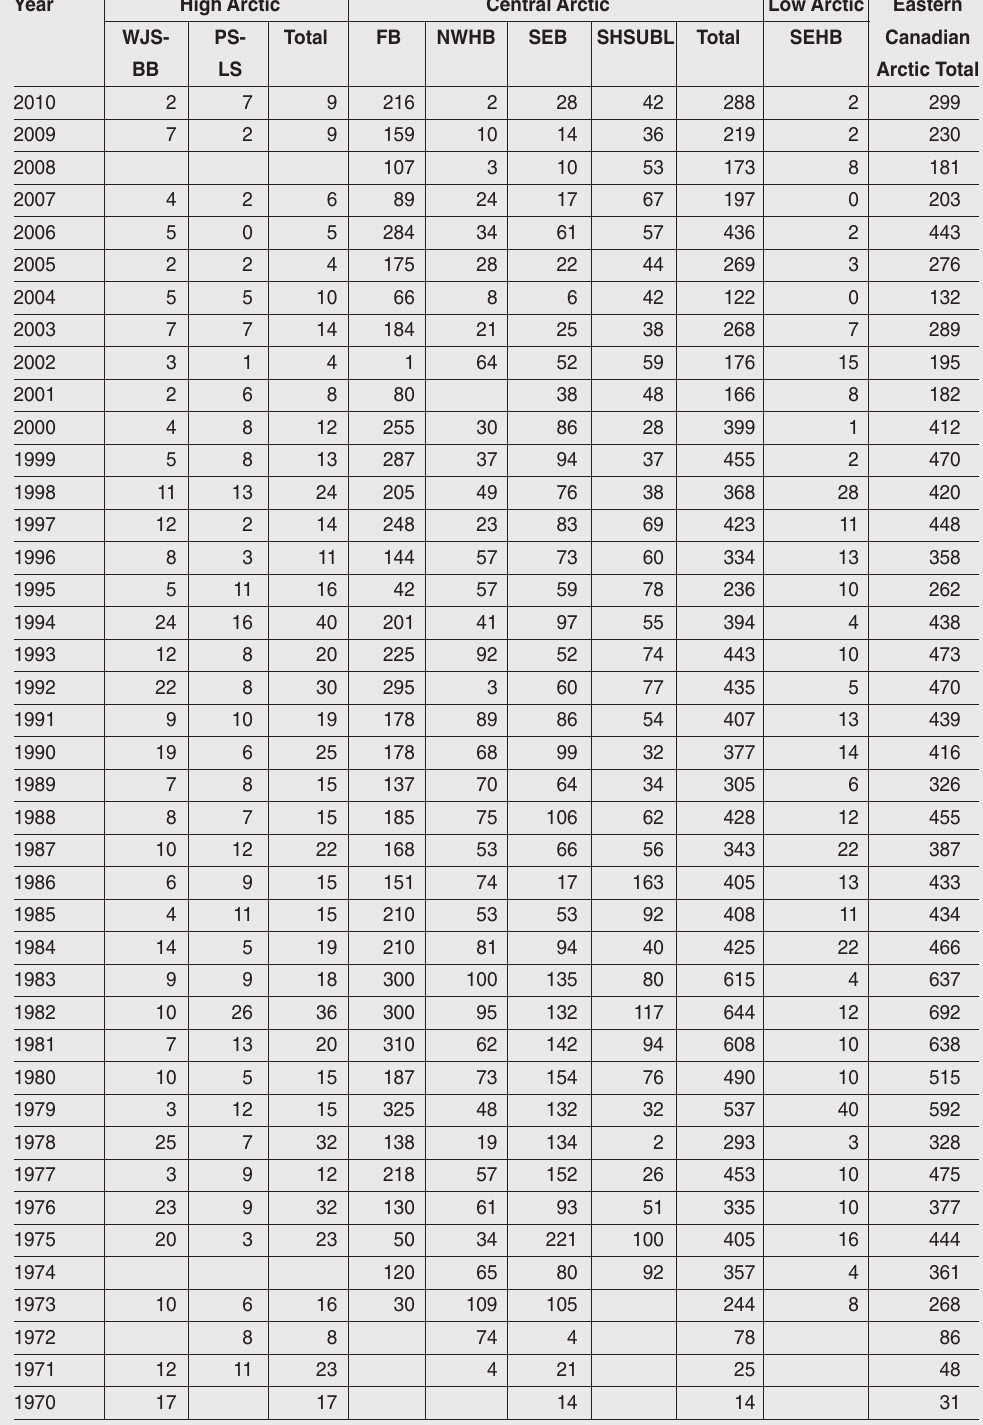
Table 4. Summary of annual landed catches reported from walrus populations in the eastern Canadian Arctic by subsistence and shore-based commercial hunts. See Supplement 4 for community